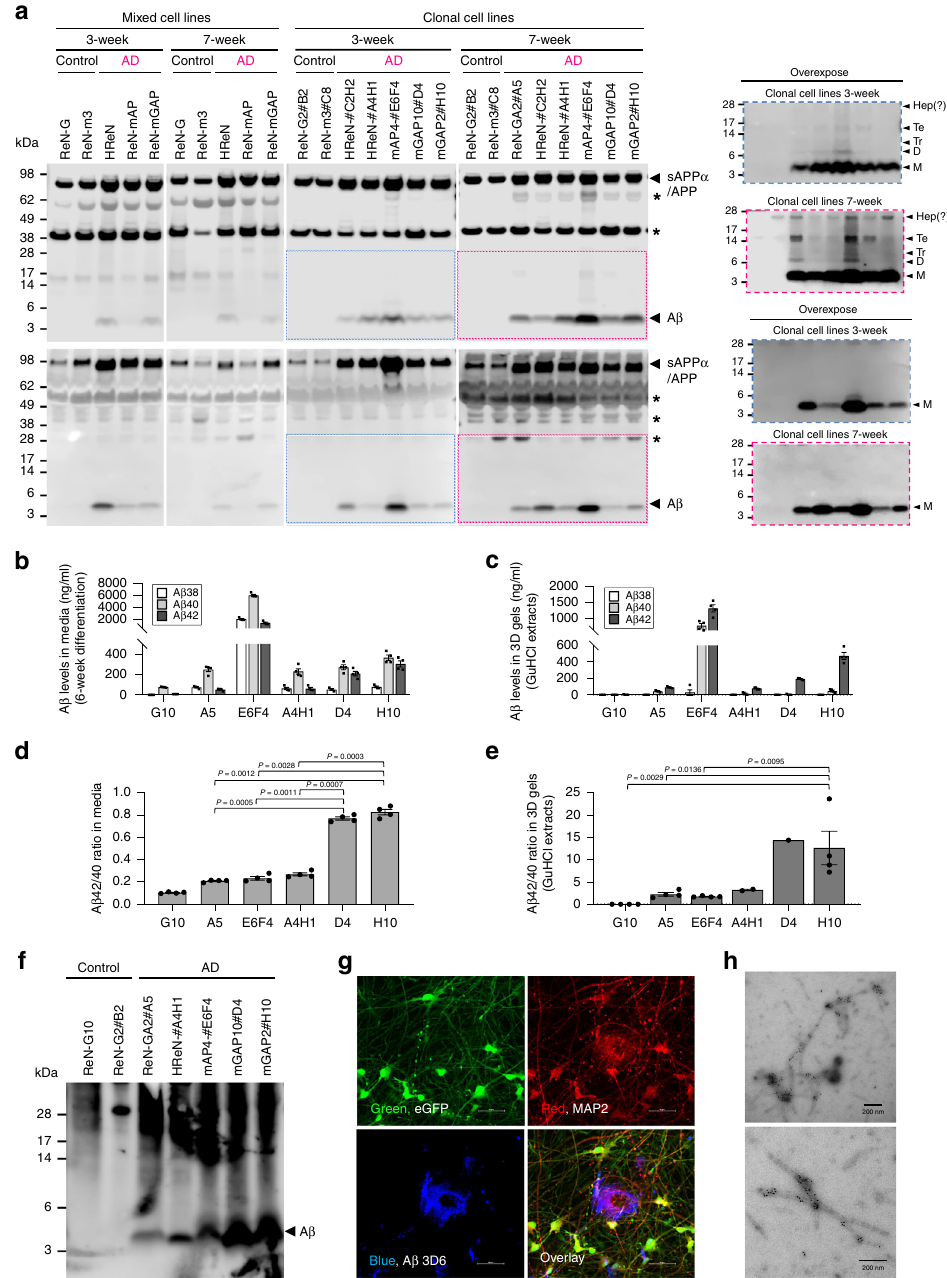
Fig. 3 Clonal FAD hNPCs with high A β 42/40 ratio showed robust accumulation of detergent-resistant A β 42 aggregates. a Comparison of accumulated A β levels between differentiated mixed and clonal AD hNPC lines in 3D gels (top panel) and media (bottom panel). Mixed and clonal hNPCs (1.2 × 10 6 ) were 3D-differentiated in 24-well plates for 3 and 7 weeks. SDS-soluble protein lysates were prepared from differentiated 3D cultures. The levels of A β peptides in both 3D gels and media were measured by Western blot analysis using anti-A β antibody (6E10). The overexposed images, in dashed line rectangles (blue: 3 weeks, red: 7 weeks), are presented on the right. Asterisk represents unidenti fi ed bands which might be partially cleaved APP fragments, large A β , or nonspeci fi c bands detected by 6E10 antibody. b – e The clonal control and FAD hNPCs (3 × 10 5 ) were 3D-differentiated in 96-well plates for 6 weeks. Concentrations of A β species (A β 38, A β 40 and A β 42) in media ( b ) and in 3D gels ( c ) were analyzed by MSD A β assay. A β 42/40 ratios based on the A β concentrations in media ( d ) and in 3D gels ( e ) were presented. Protein extracts from 3D-differentiated clonal hNPCs were prepared using 5 M guanidine hydrochloride (GuHCl). All data are expressed as mean ± SEM of four independent repeats (black dots). Statistical signi fi cances were determined by one-way ANOVA with Tukey ’ s multiple comparisons test. A β values below the detection limit of the MSD A β assay were excluded from calculation of A β 42/40 ratio. Graphs represent only data validated by MSD A β assay. f Clonal hNPCs (8 × 10 6 ) were 3D-differentiated in 6-well plates for 6 weeks. Samples were harvested and dissolved in 1% sarkosyl lysis buffer. Sarkosyl-insoluble fractions reveal aggregated A β species. g ReN-mGAP10#D4 cells were differentiated in 3D cultures for 6 weeks. After fi xing with 4% paraformaldehyde, cells were immunostained with antibodies against A β (3D6) and MAP2. The extracellular A β deposition and MAP2-positive cells were imaged by confocal microscopy. h Representative electron micrographs show A β fi brils. Detergent-insoluble fractions were puri fi ed from 3D-differentiated ReN-mGAP10#D4 for 9 weeks. A β fi brils were labeled with anti-A β antibody (3D6)-conjugated gold